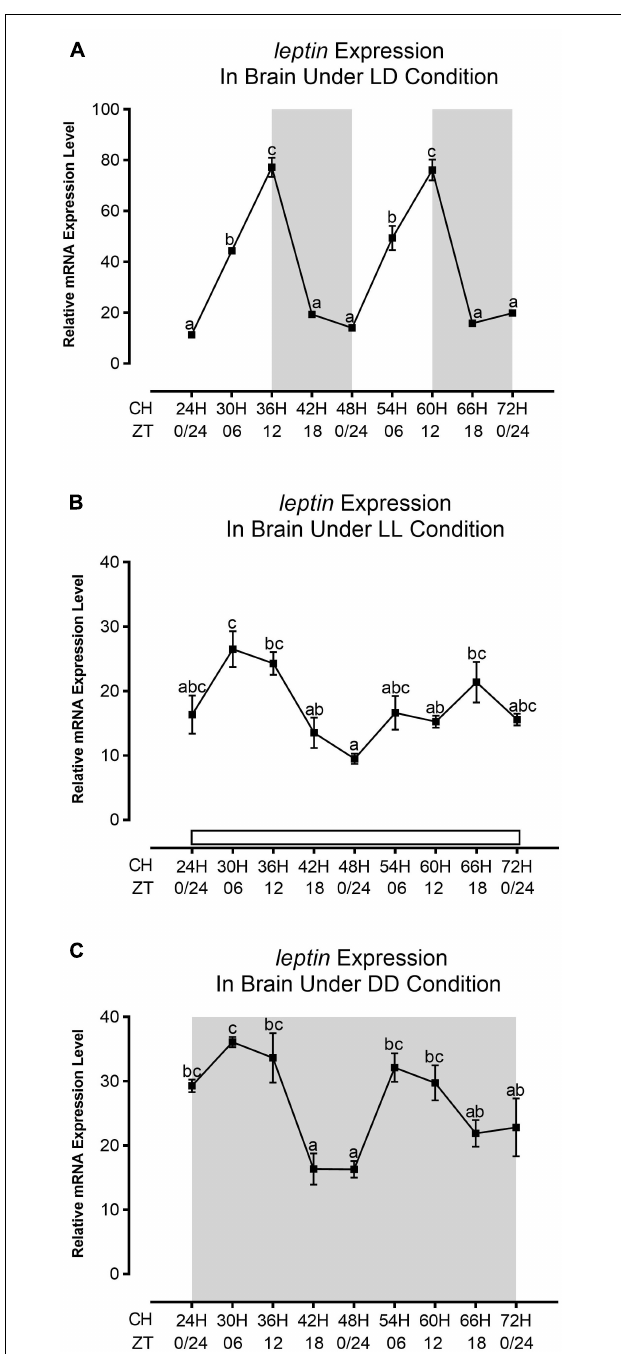
FIGURE 2 | Daily expression profile of leptin gene under different photic conditions (LD, LL, and DD) in the brain of zebrafish. The daily expression profile of leptin mRNA at (A) LD, (B) LL, and (C) DD. The relative quantification values in the graph are shown as the mean ± SEM ( n = 3). Different letters indicate significant differences evaluated by one-way ANOVA [ (A) F (8,18) = 109.908, p = 0.000, (B) F (8,18) = 5.926, p = 0.001, and (C) F (8,18) = 8.012, p = 0.000] followed by post-hoc Tukey’s test ( p < 0.05). The gray background resembles the dark phase and the white background is for the light phase. CH and ZT in the x -axis stand for Clock Hour and Zeitgeber Time,